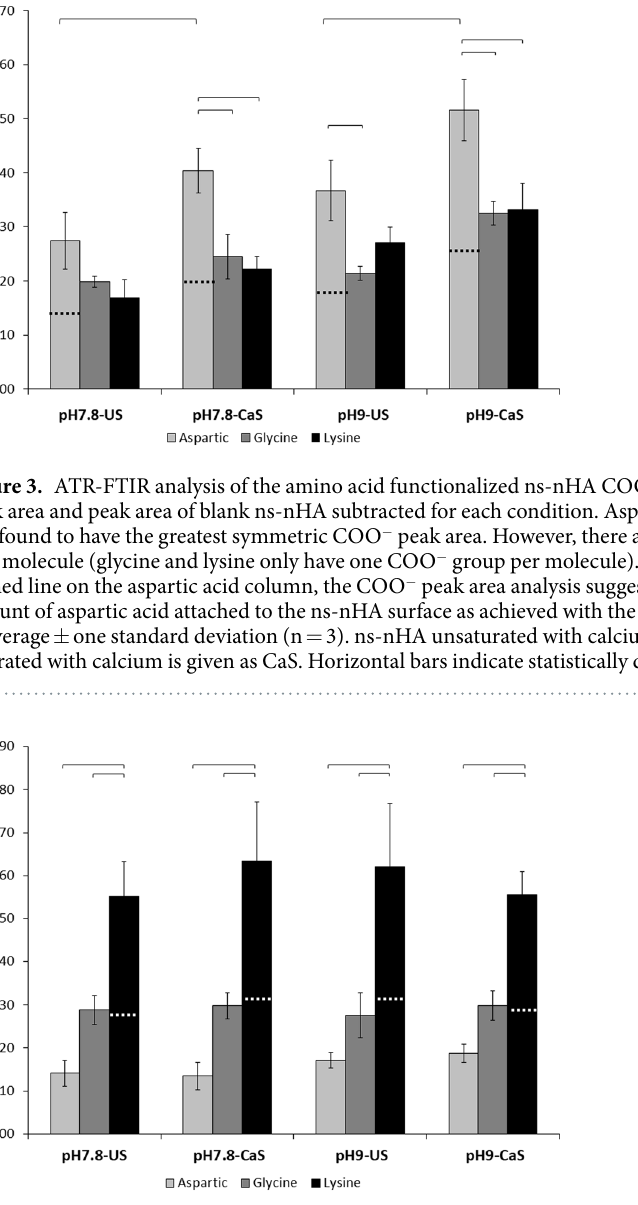
sites originally available for grafting on ns-nHA is shown in Fig. 5 for the ninhydrin protocol and Fig. 6 for the fluoraldehyde method. A three-factor general linear model analysis of the ninhydrin protocol data revealed that the interaction of reaction pH and amino acid type is detectably different (p < 0.0001). Meanwhile, reaction pH (p < 0.0001), pre-saturation of ns-nHA with calcium (p = 0.036), and amino acid type (p < 0.0001) were each found to inde- pendently impact the fraction of sites grafted. As a result, only lysine sees a detectable increase in attachment to ns-nHA as pH increases. A similar model analysis of the fluoraldehyde assay data also indicated that the inter- action of reaction pH and amino acid type was detectable (p = 0.004). Furthermore, and as with the ninhydrin protocol, reaction pH (p < 0.0001), pre-saturation of ns-nHA with calcium (p = 0.009), and amino acid type (p < 0.0001) were each found to independently impact the fraction of sites grafted as per the fluoraldehyde assay.